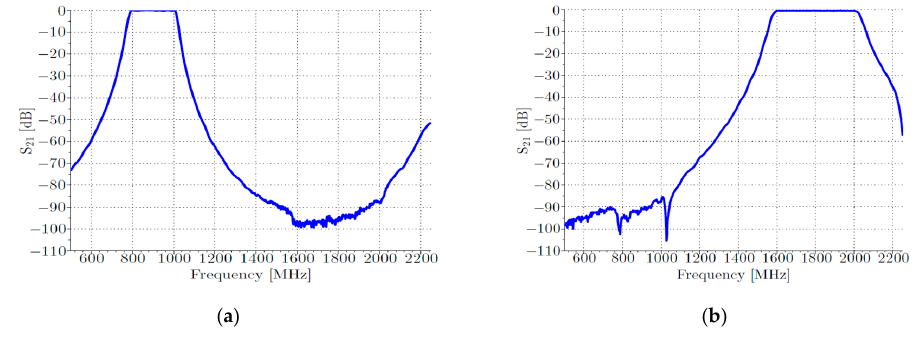
Figure 9. Measured | S 21 | response for Reactel diplexers for various ports: ( a ) low-frequency port; and ( b ) high-frequency port.